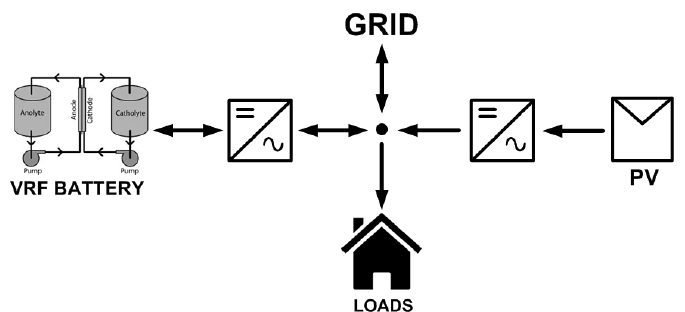
Figure 1. Demonstrator (photovoltaic (PV) plant and Vanadium Redox Flow battery (VRFB) with respective converters) simplified schematic. Inverters convert power from PV and battery (DC) to the grid